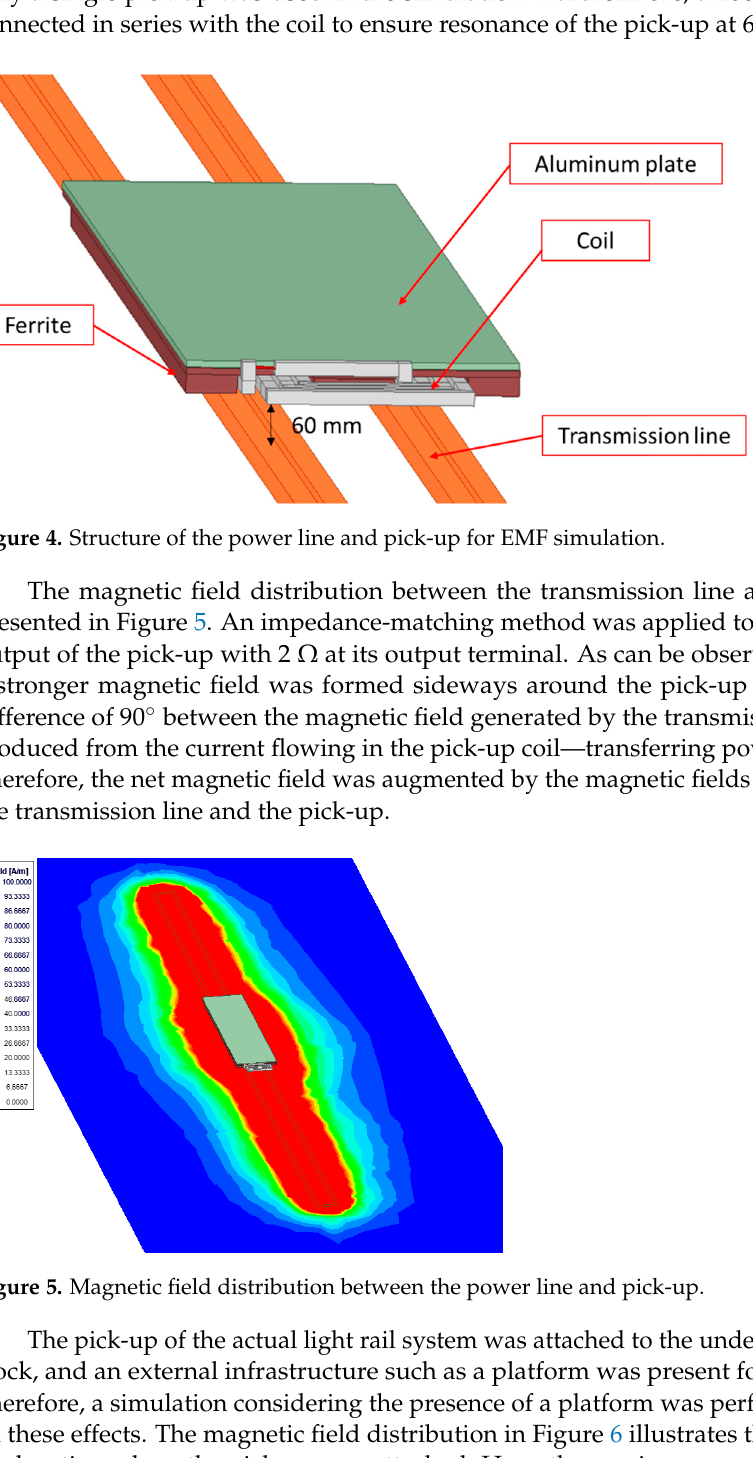
Figure 5. Magnetic field distribution between the power line and